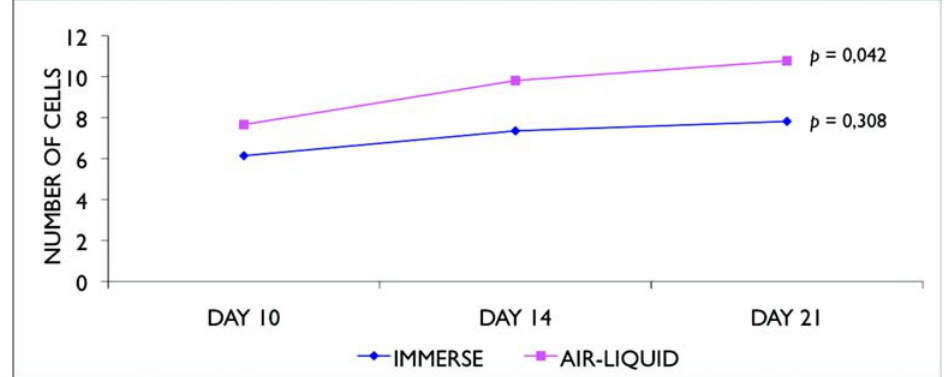
FIGURE 4 - Increasing number of keratinocytes throughout the study with no statistical interaction. Air-liquid interface culture system with significant increase ( p =0.042) from day 10 to day 21.